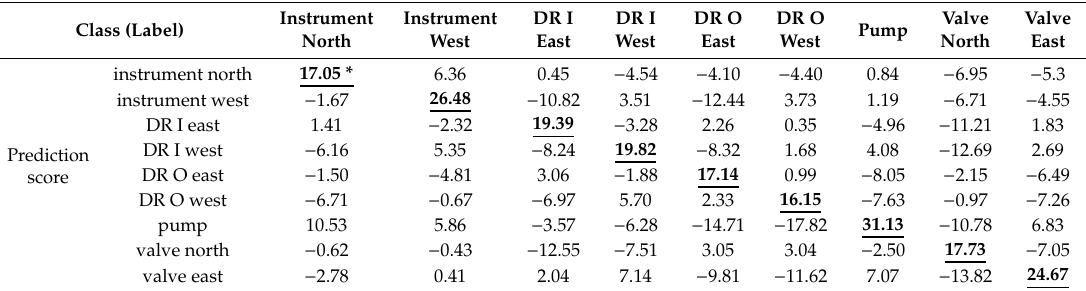
Table 1. Prediction scores for trained symbol types.